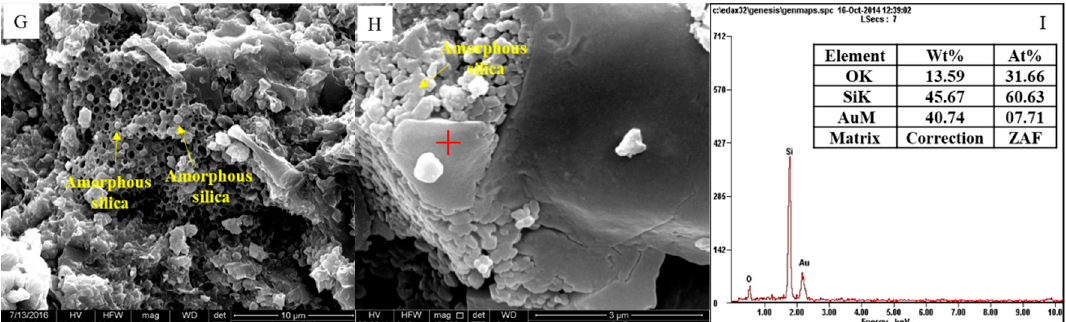
Figure 3. SEM images of quartz and amorphous silica in the Lucaogou Formation, Jimsar Depression. ( A ) Transitional lithofacies, S1 well, 3147.64 m; ( B ) tuffaceous shale lithofacies, S2 well, 3348.08 m; ( C )